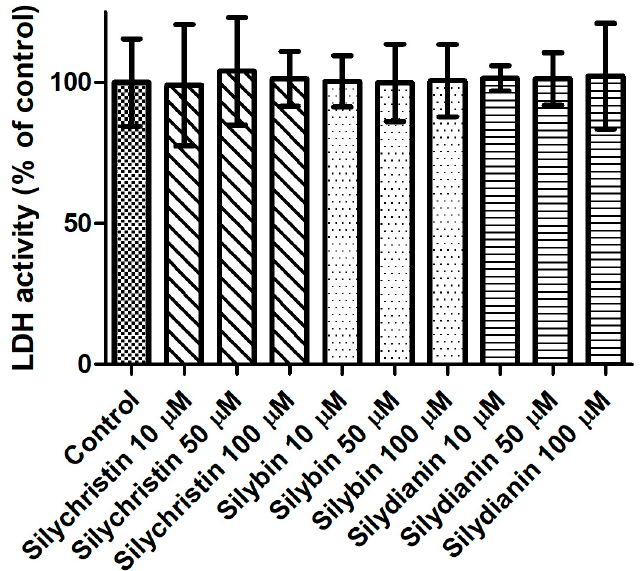
Figure 2. The effect of flavonolignans (silychristin, silybin and silydianin in concentrations of 10, 50 and 100 µM) on lactic dehydrogenase release from blood platelets. The results are expressed as a percentage of LDH activity in the control samples (without tested compounds). The data represent means of ± SD, n = 12.